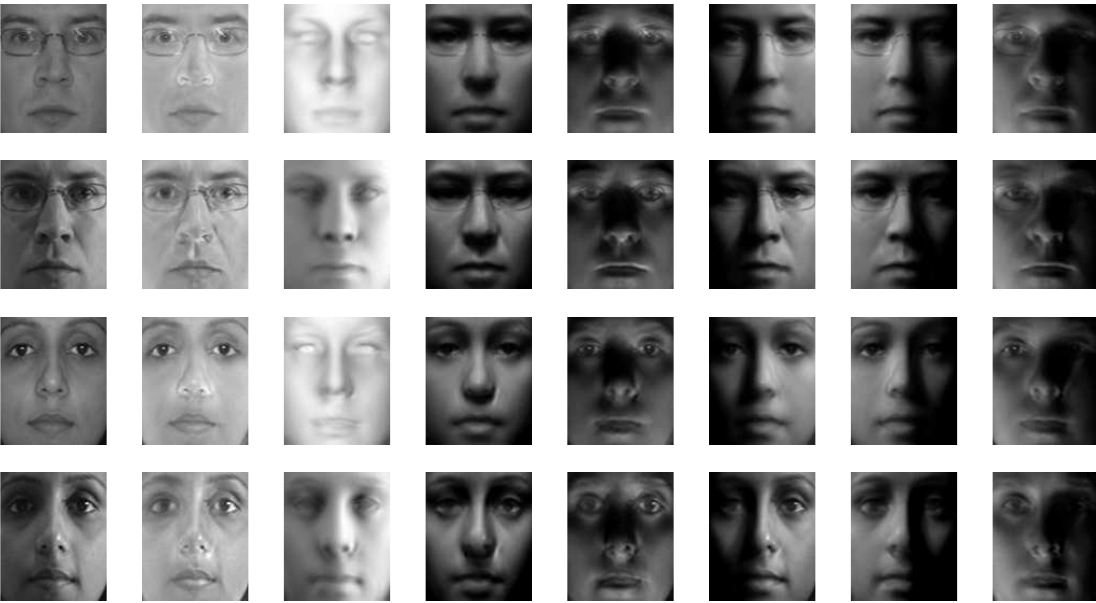
Figure 6. Relit images based on the Multi-PIE database (1st column: input image; 2nd: recovered texture; 3rd: estimated illuminance; and 4–8th: relit